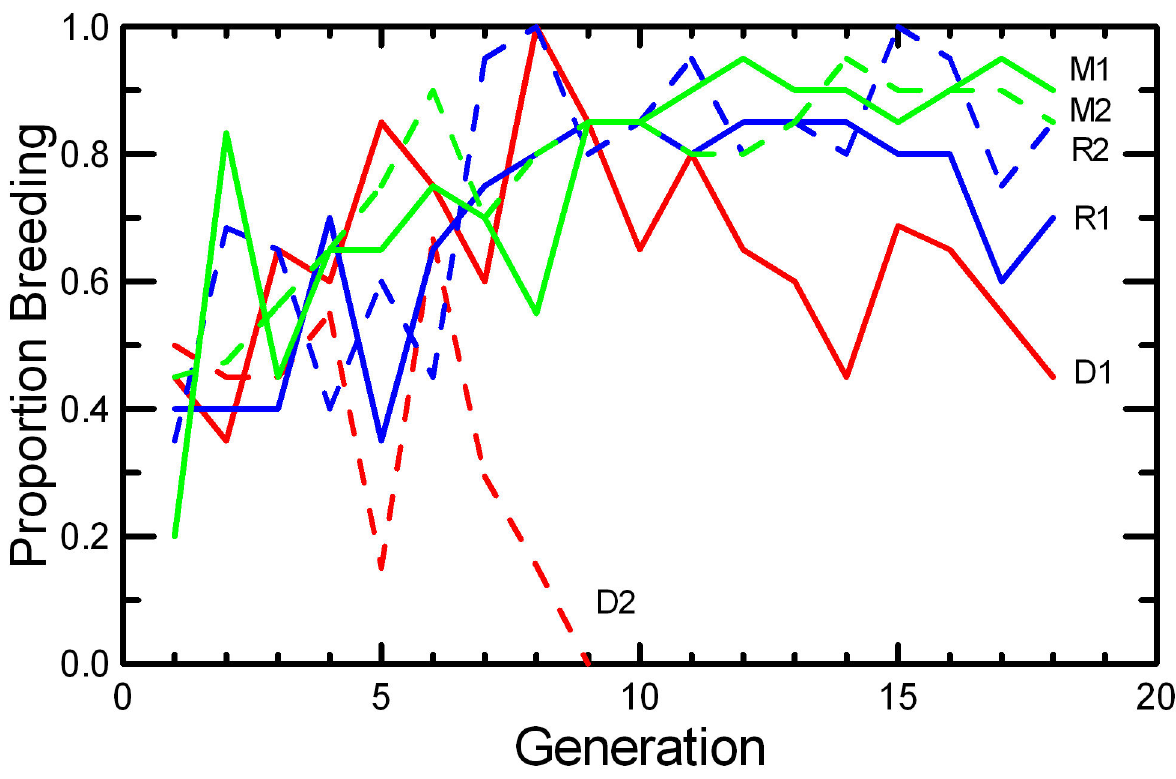
Figure 5. Probability that a pair will breed. The proportion of pairs that produced at least one litter conceived within 70 days is given for the two replicates of RAN (blue), MK (green), and DOC (red) experimental populations. doi: